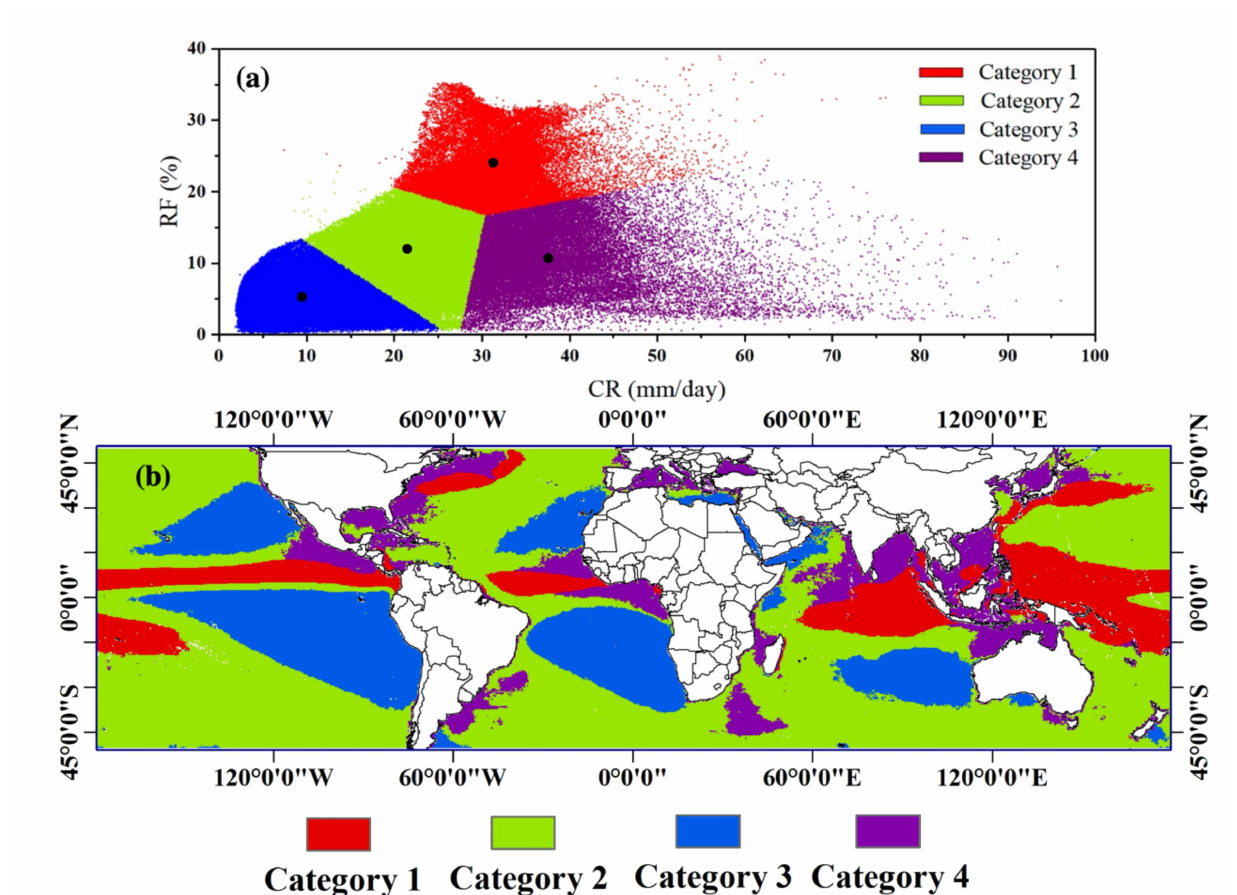
Figure 7. ( a ) K-means clustering based on mean RF and CR for ocean, black dots are the centroids of each cluster. ( b ) Distributions of precipitation categories over